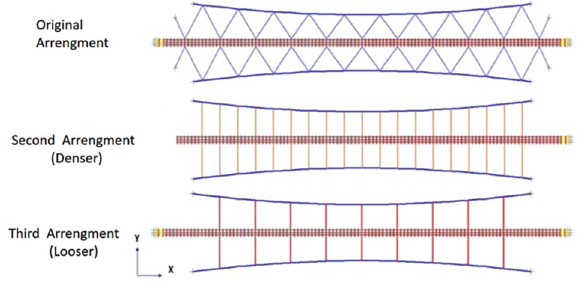
Figure 20. Three arrangements of steel cables